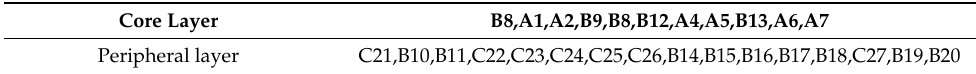
Table 5. Results of peripheral